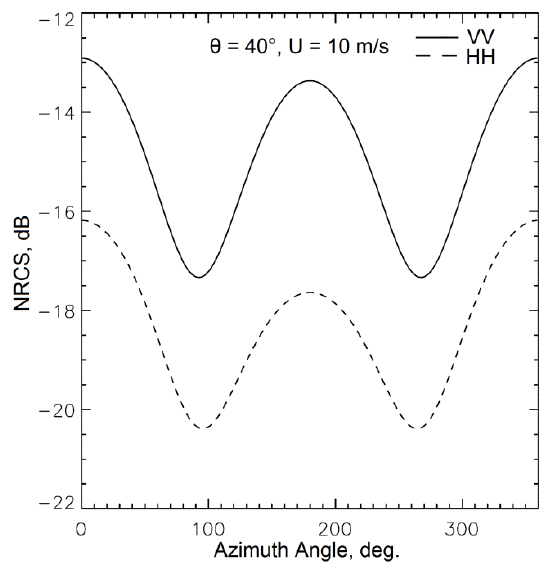
Figure 4. Example of the C-band azimuthal NRCS for VV and HH polarization at the incidence angle of 40° and wind speed of 10 m/s.